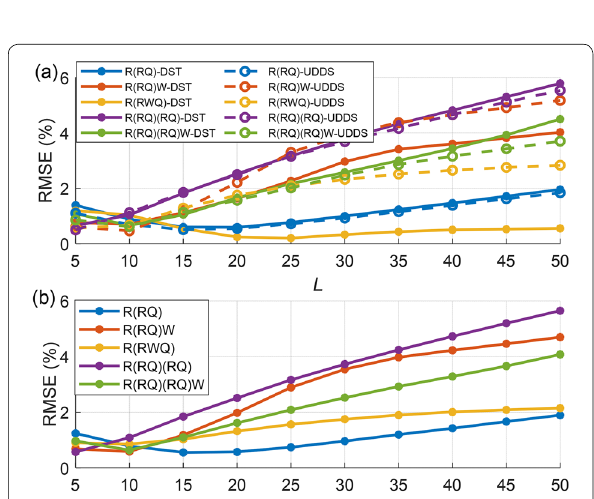
Figure 7 RMSE of five FOMs